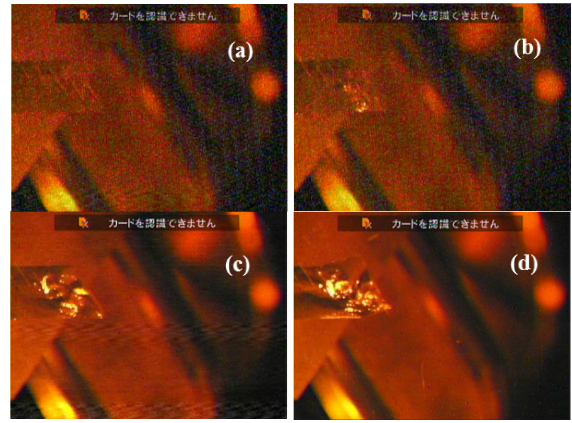
Fig. 8. Observation of J-HBC foil during user beam operation. (a) before irradiation, (b) trial test with MLF user beam for 30 min, (c) trial test with NU user beam for 5 min, and (d) after MLF and NU user operation for 1